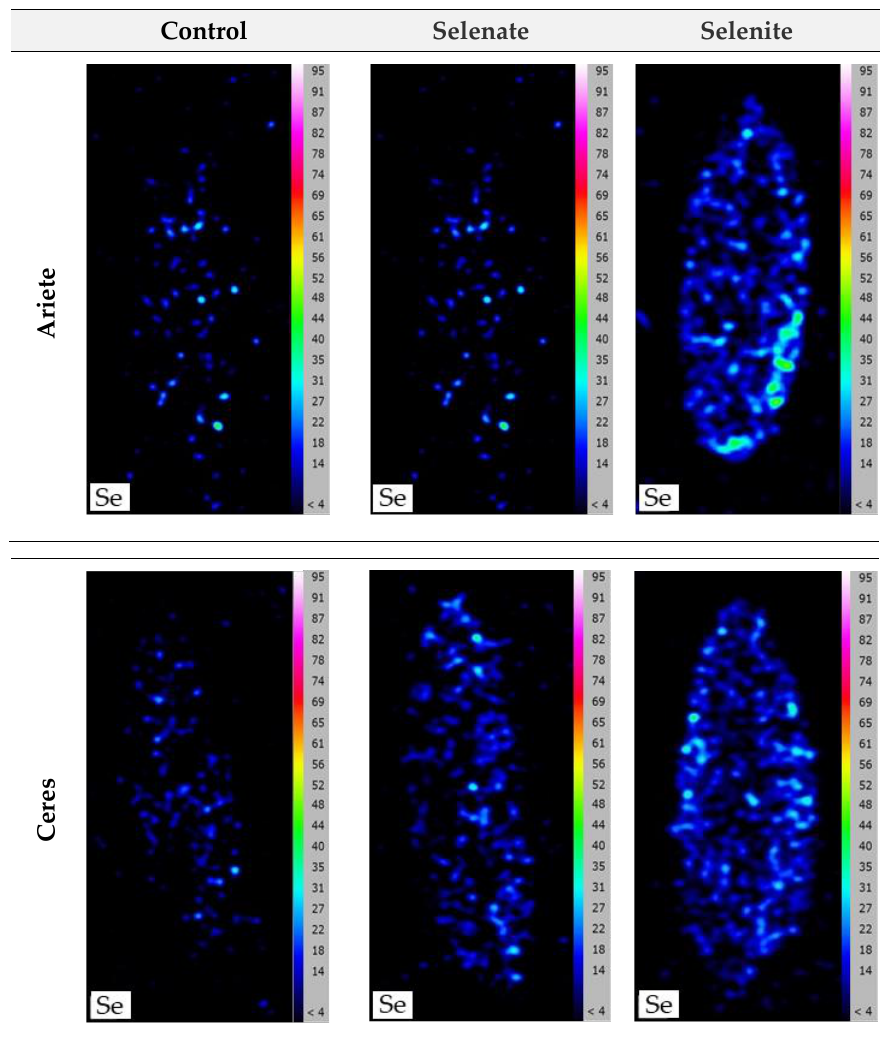
Figure 3. Localization of Se in brown rice grains of Ariete and Ceres varieties without receiving any type of Se enrichment (control) and after foliar pulverization with selenate and selenite (300 g Se. ha −1 ).